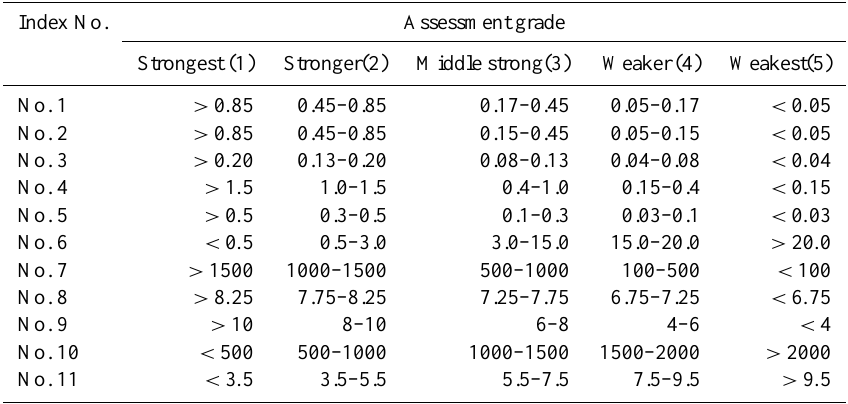
Table 4. Assessment standard based on the data of the whole China. Index